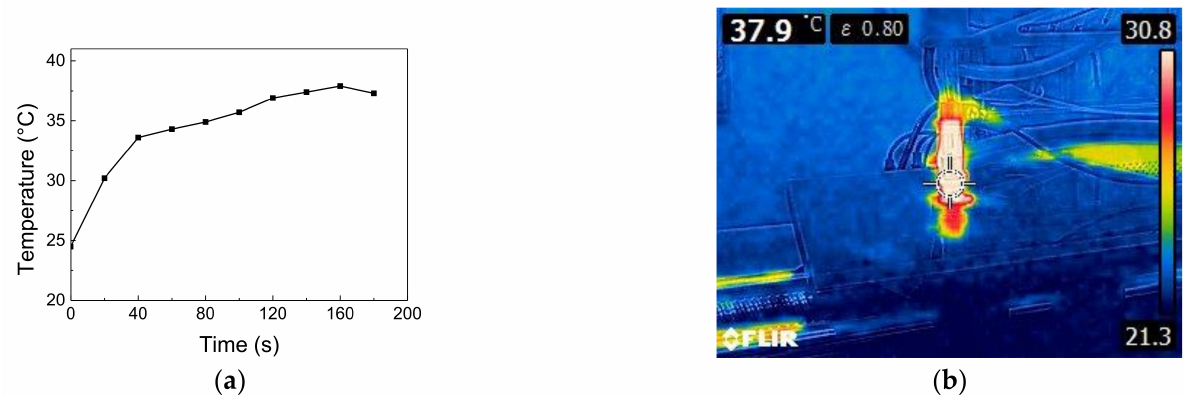
Figure 1. ( a ) Working temperature and ( b ) infrared thermal image during DBDjet